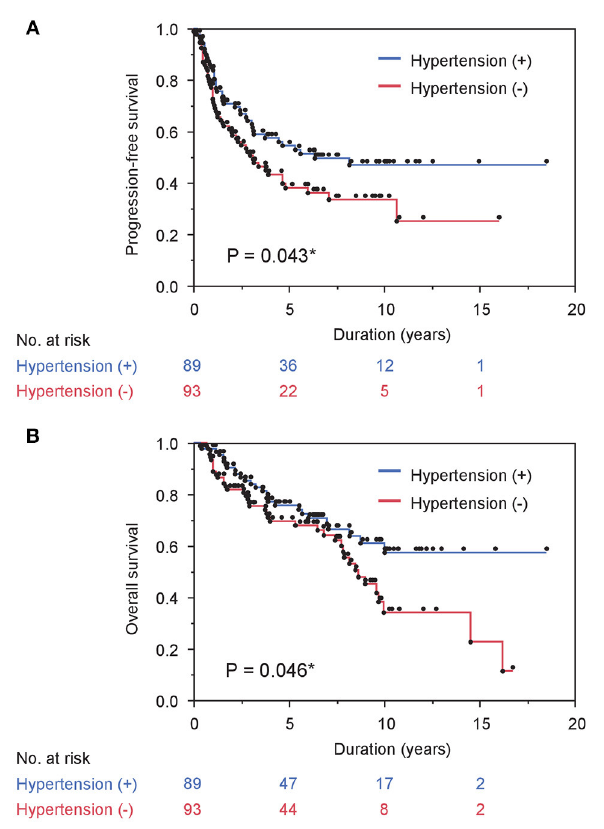
FIGURE 2 | Comorbidity with hypertension correlates with survival in prostate cancer cases treated with ADT. (A) and (B) PFS (A) and OS (B) stratified by comorbidity with hypertension are